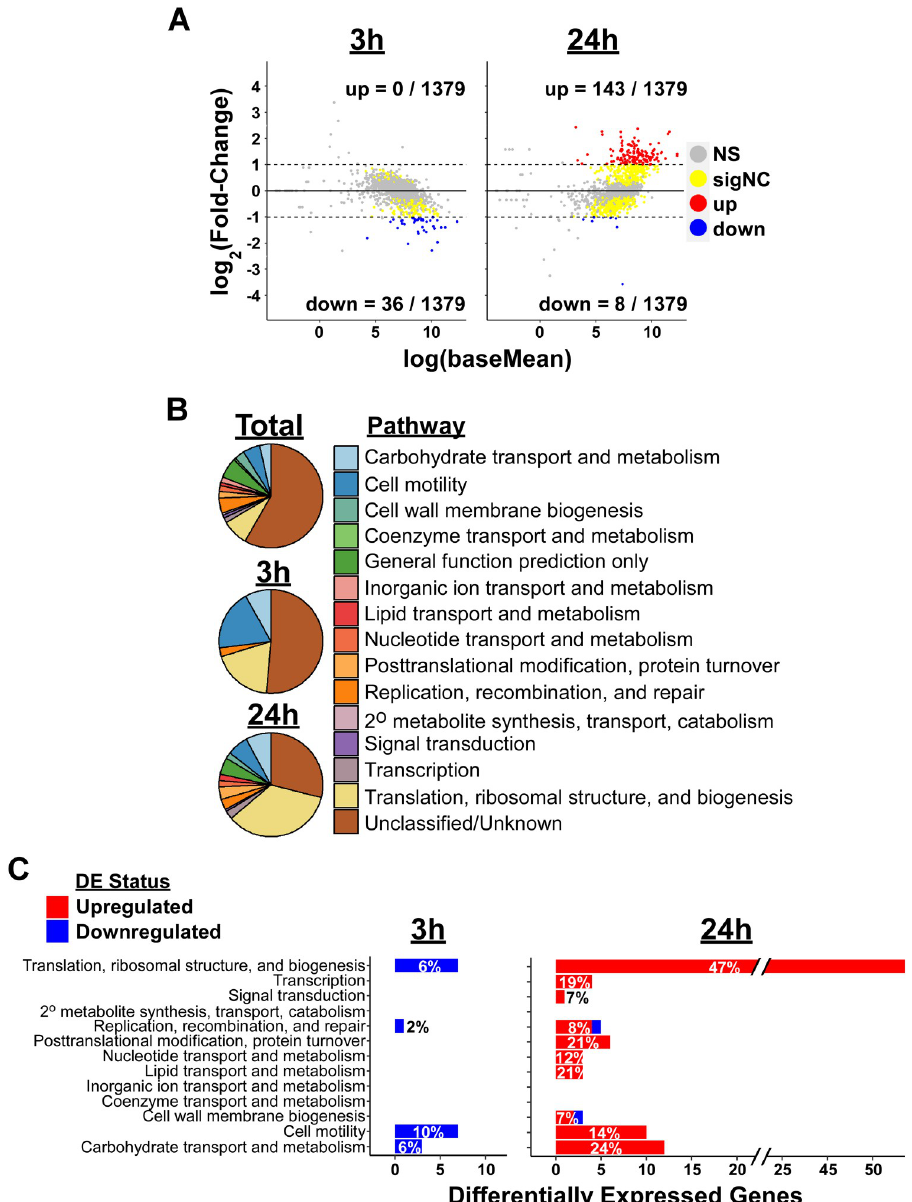
Fig 2. Doxycycline induced gene expression changes associated with protein translation. (A) Fold change versus expression strength for all detectable genes after 3 or 24 hours doxycycline treatment compared to untreated controls. Red (increased) and blue (decreased) dots represent genes with significantly different levels in treated vs. control bacteria ( α = 0.05, log 2 (fold-change) > 1). Yellow dots represent significantly different expression ( α = 0.05) without meeting our fold-change cutoff for differential expression (“sigNC”). Gray dots represent genes that were not significantly different between treatment and control bacteria (“NS”). Numbers of significantly upregulated (up) and downregulated (down) genes are shown as proportions of all detectable genes. (B) Clusters of Orthologous Genes (COG) pathways displayed as proportion of all detectable genes (“Total”) compared to differentially expressed genes after 3h or 24h of doxycycline treatment [47]. (C) Stacked bar graph showing the number of increased (red) and decreased (blue) genes in each COG pathway at 3h and 24h timepoints. Percentage of genes in each pathway that were differentially expressed is stated within each bar. Note: Unclassified and general function prediction not